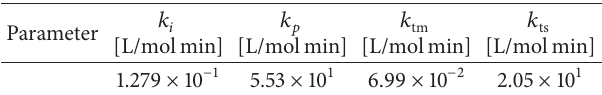
Table 4: Kinetic parameters used by Banu et al. [25] for the L-lactide (initiator SnOct 2 /TPP) polymerization